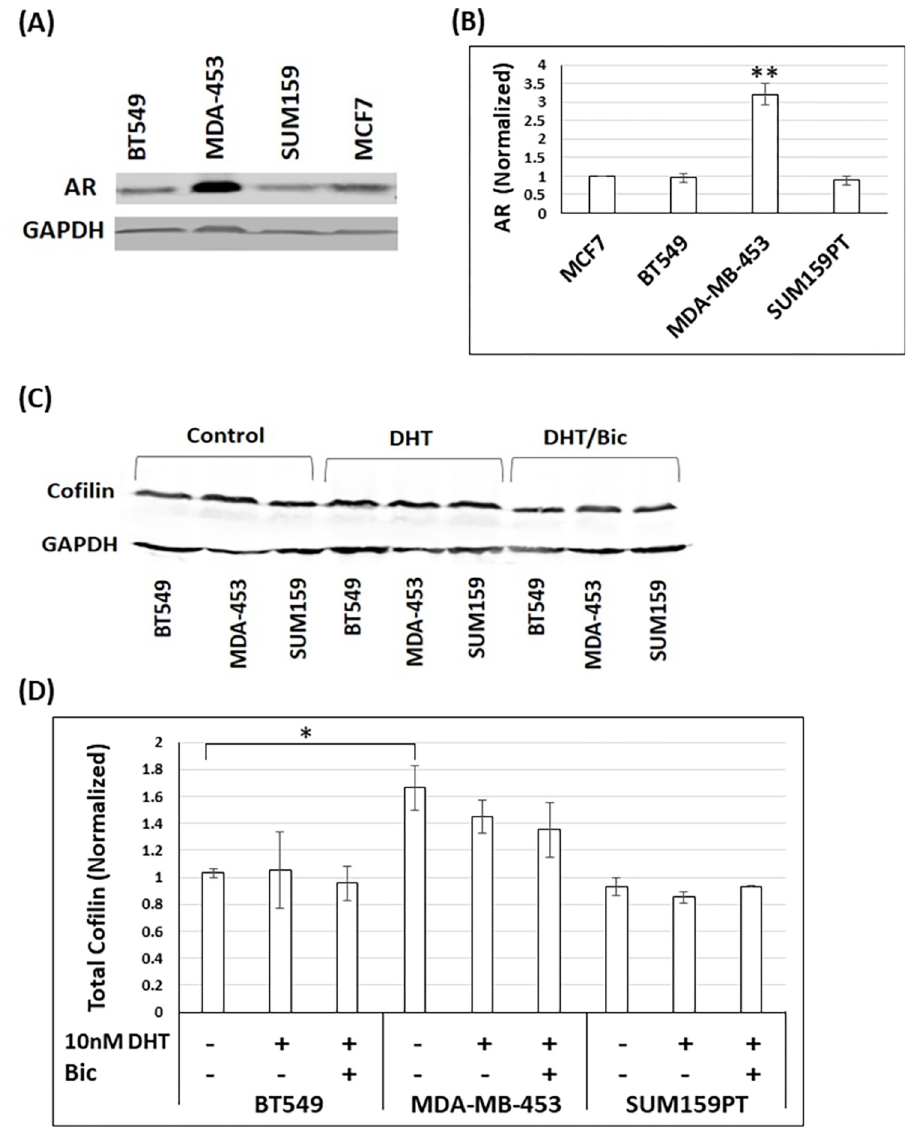
Fig 1. TNBC cell lines express different protein levels of AR and cofilin-1 (cofilin). (A) Representative western blot of lysates from vehicle-treated TNBC and MCF7 cells immunolabeled with AR antibody and a monoclonal antibody to GAPDH as a loading control. The experiment was repeated three times and the corresponding quantification is shown in (B). (B) Quantification of AR protein level in the different TNBC cell lines relative to its level in MCF7 cells [set as 1.0 arbitrary unit (a.u.)] obtained from densitometers of immunoblots. �� p < 0.01 versus MCF7 cells. (C) Representative western blot of lysates from control vehicle-treated, 10 nM DHT (DHT)-treated, and 10 nM DHT/ bicalutamide (Bic)-treated TNBC cells immunolabeled with mAb22 antibody and GAPDH as a loading control. The experiment was repeated three times and the corresponding quantification is shown in (D). (D) Quantification of total cofilin protein levels in TNBC cells relative to its level in control BT549 cells (set as 1.0 a.u.) obtained from densitometers of immunoblots. � p < 0.05 versus control BT cells.